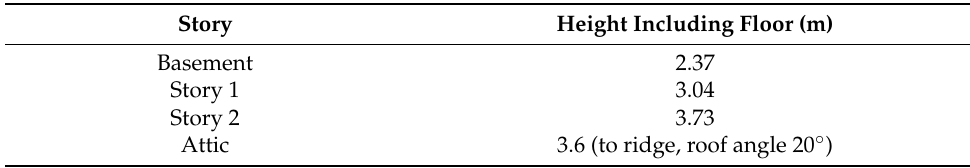
Table 1. Specifications of stories of